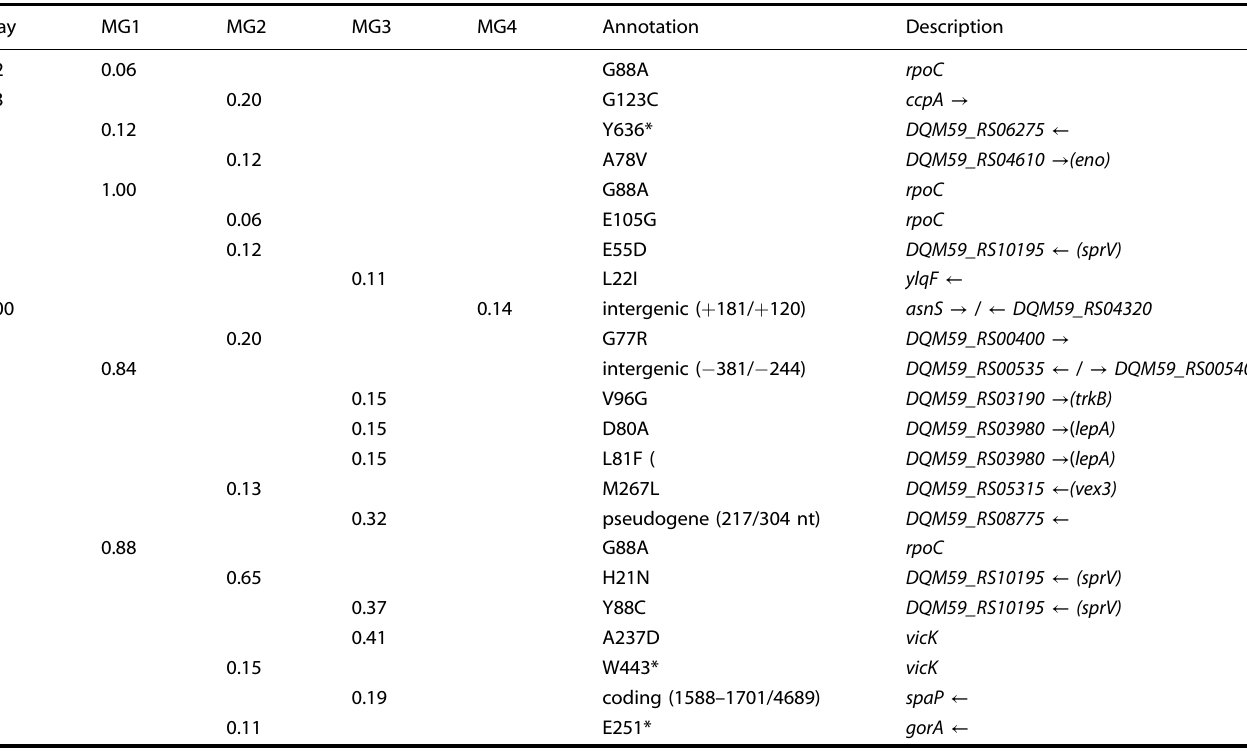
*Indicates premature stop codons. C indicates in the coding region. I indicates intergenic